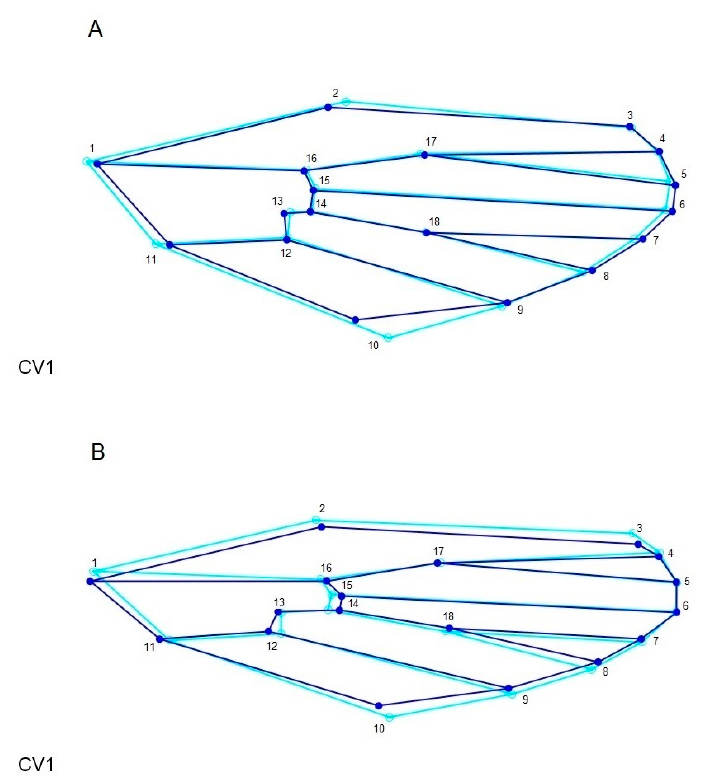
Figure 5. Superimposed wireframe graphs of Aedes scapularis ( A ) and Aedes albopictus ( B ). The light blue lines represent the medium wing shape variation for all populations and the dark blue lines represent the shape variance based on CV1.